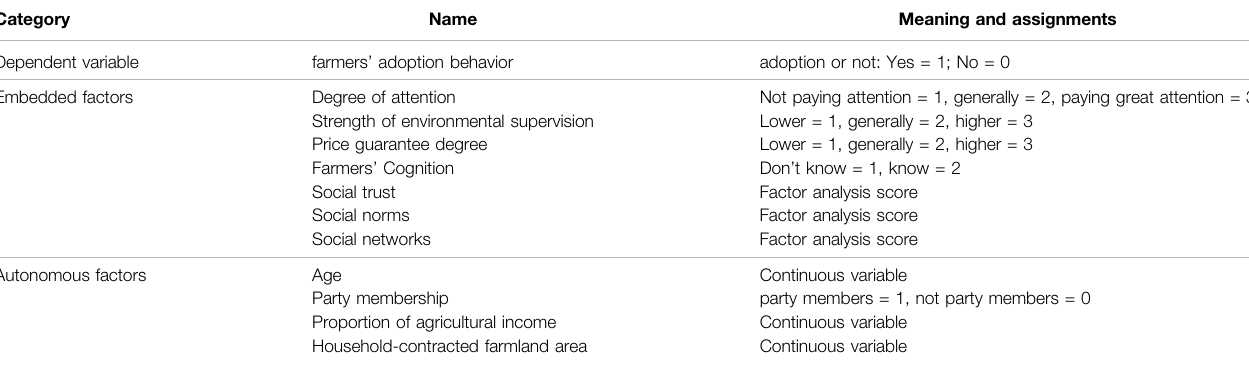
TABLE 1 | Meaning and assignments of